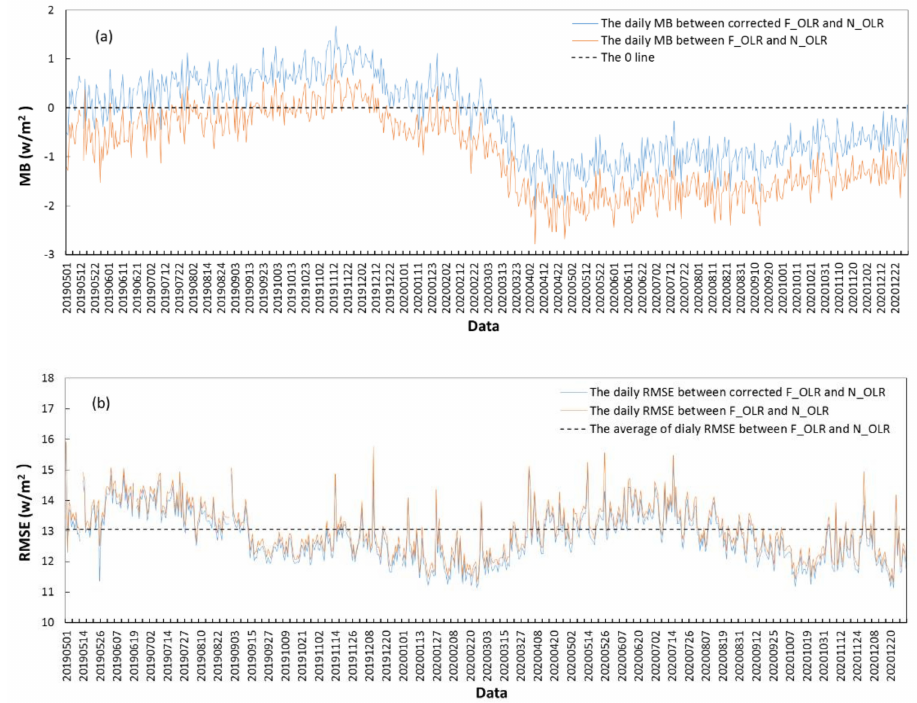
Figure 3. Variations in the global daily average of ( a ) the MB and ( b ) the root mean square error (RMSE) between F _OLR and N _OLR and between the corrected F _OLR and N _OLR . In addition, the averages of the pentad (a time period of 5 days) and monthly MB and RMSE between F _OLR and N _OLR were both calculated from May 2019 to December 2020 (Figures 4 and 5 and Table 1). The averages of the pentad and monthly MB between F _OLR and N _OLR are − 1.33 W/m 2 and − 1.53 W/m 2 , respectively, and the absolute values of MB increase with the increase in the time scale from a day to a month. However, the averages of the pentad and monthly RMSE between F _OLR and N _OLR are 6.54 W/m 2 and 4.20 W/m 2 , respectively, and the mean RMSE deceases with the increase in the time scale from a day to a